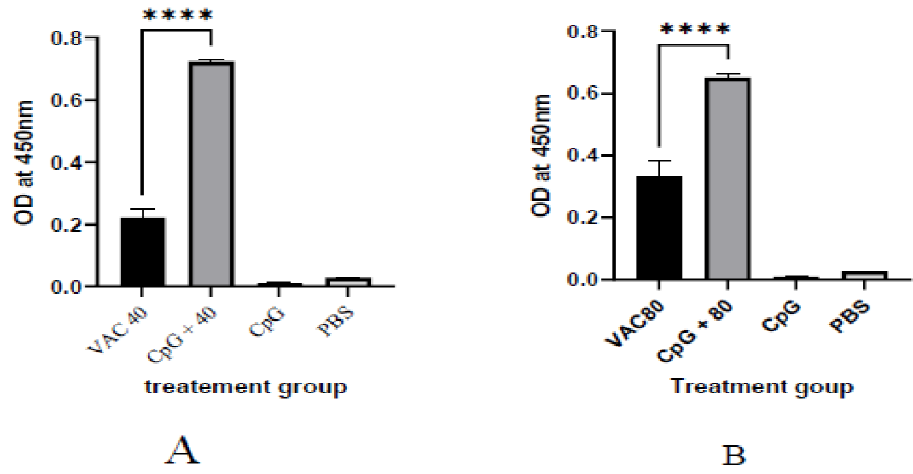
Figure 1. The IgG antibody immune response to SARS-CoV-2 at 14 days after immunization. ( A ) The results of SARS-CoV-2 spike protein-specific IgG antibodies in the plasma of 4 × 10 9 VP of vaccine plus the CpG ODNS group showed statistical significance ( p ≤ 0.001), 2-fold increase in IgG against 4 × 10 9 VP of vaccine. ( B ) The results of SARS-CoV-2 spike protein-specific IgG antibodies in the plasma of 8 × 10 9 VP of vaccine plus the CpG ODNs group. There was a 1.5-fold increase for the CPG-supplemented against 8 × 10 9 VP of the vaccine-only group. A 95% CI was considered for all tests. (**** p < 0.0001).